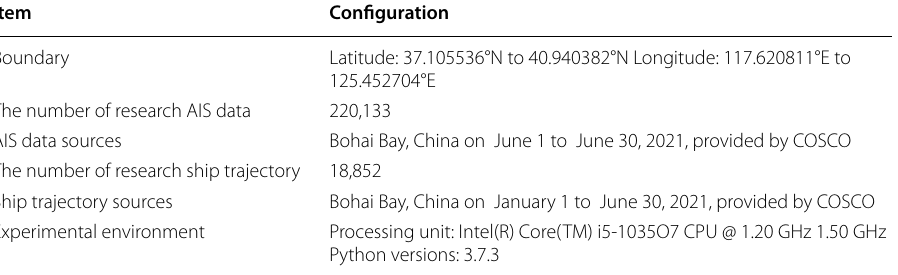
Table 1 The configuration of the case study